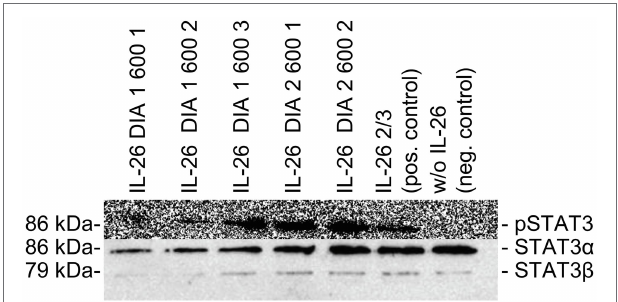
FIGURE 1 | Western blot analyses of COLO-205 cell lysates treated with different batches of IL-26 dialysates, positive control, and negative control. Top: Detection of phospho-STAT3 using primary polyclonal rabbit-raised phospho-STAT3 antibodies. Bottom: Detection of STAT3 α and STAT3 β using primary polyclonal rabbit-raised STAT3 antibodies. For both analyses, horseradish peroxidase-conjugated anti-rabbit IgG antibodies were used as second reagents. Chemiluminescence detection was performed with a charge-coupled device camera (LAS-3000, Fujifilm,